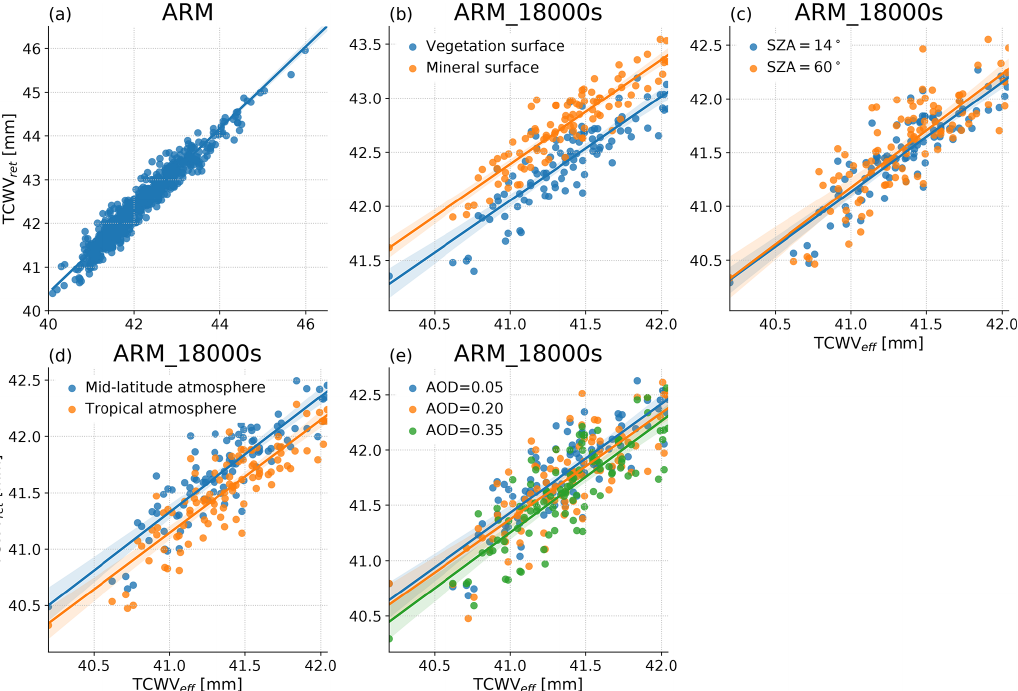
Figure 2. TCWV ret as a function of TCWV along with emulator fits: (a) for subsets from all ARM snapshots with SZA = 45 ◦ over a cropland surface. (b) Over two typical different surfaces, ARM_18000s only, (c) with different SZAs, (d) when changing a retrieval’s assumed q(z) and T (z) , and (e) when changing AOD.